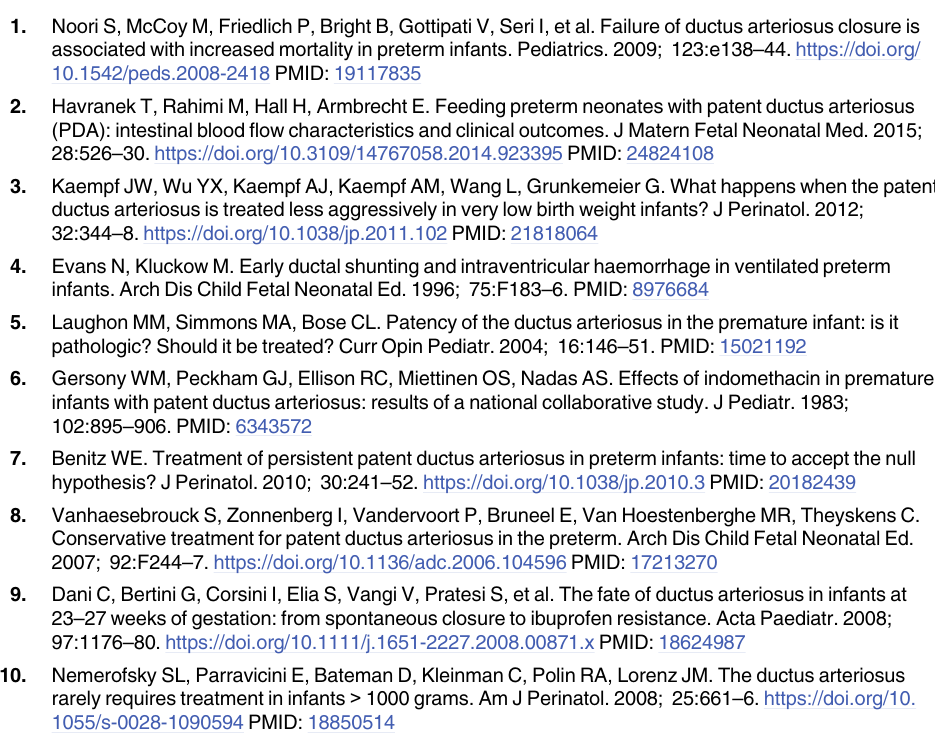
S3 Table. Adverse outcomes of infants with or without HS PDA according to gestational age subgroup. HS, hemodynamically significant; PDA, patent ductus arteriosus; GA, gesta- tional age, � p value < 0.05 versus HS-PDA